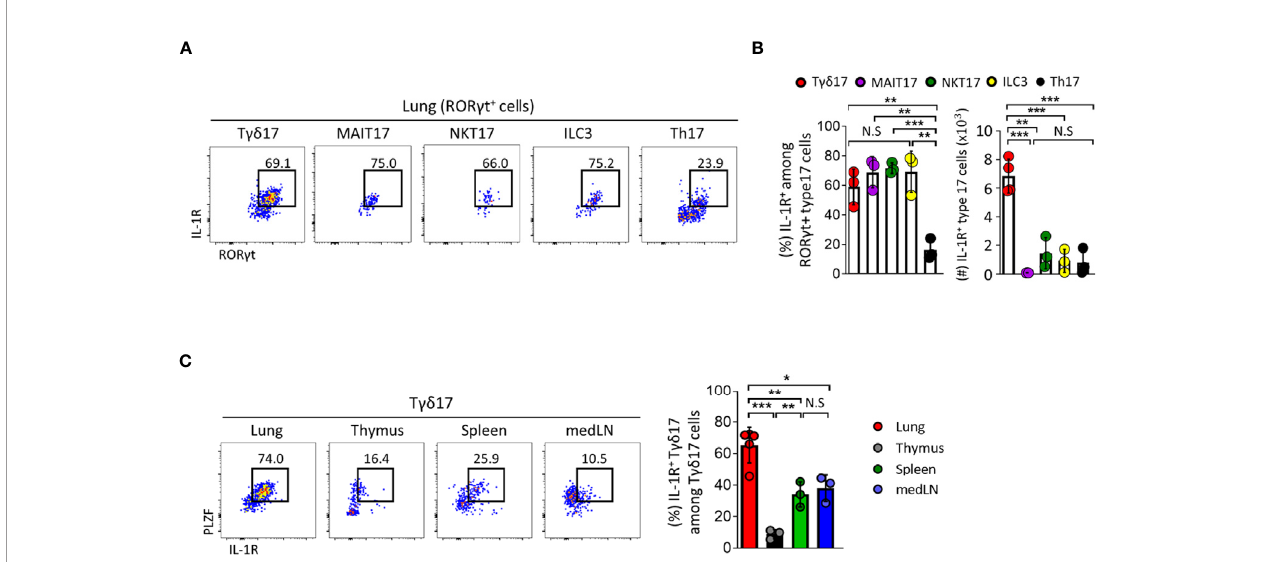
FIGURE 4 | Type 17 innate T cells express IL-1R in the lung. (A – C) IL-1 receptor (IL-1R) expression was analyzed by fl ow cytometry on type 17 innate T cells, innate lymphoid cells (ILC3) and T helper (Th17) cells in indicated tissues from B6 SPF adult mice at steady state. (A) Representative dot plots show pulmonary IL- 1R-expressing T gd 17, mucosal associated invariant T (MAIT17), natural killer T (NKT17), ILC3, and Th17 cells. (B) Bar graphs show statistical analysis of frequencies and absolute numbers of (A) . (C) Representative dot plots show PLZF and IL-1R expression of T gd 17 cells in indicated tissues. Numbers indicate frequencies of cells in adjacent gates. Data are representative of at least two independent experiments and error bars indicate ± SD. medLN, mediastinal lymph nodes. Unpaired two- tailed t -test and one-way ANOVA was used. N.S, not signi fi cant, *P < 0.05, **P < 0.01, ***P <